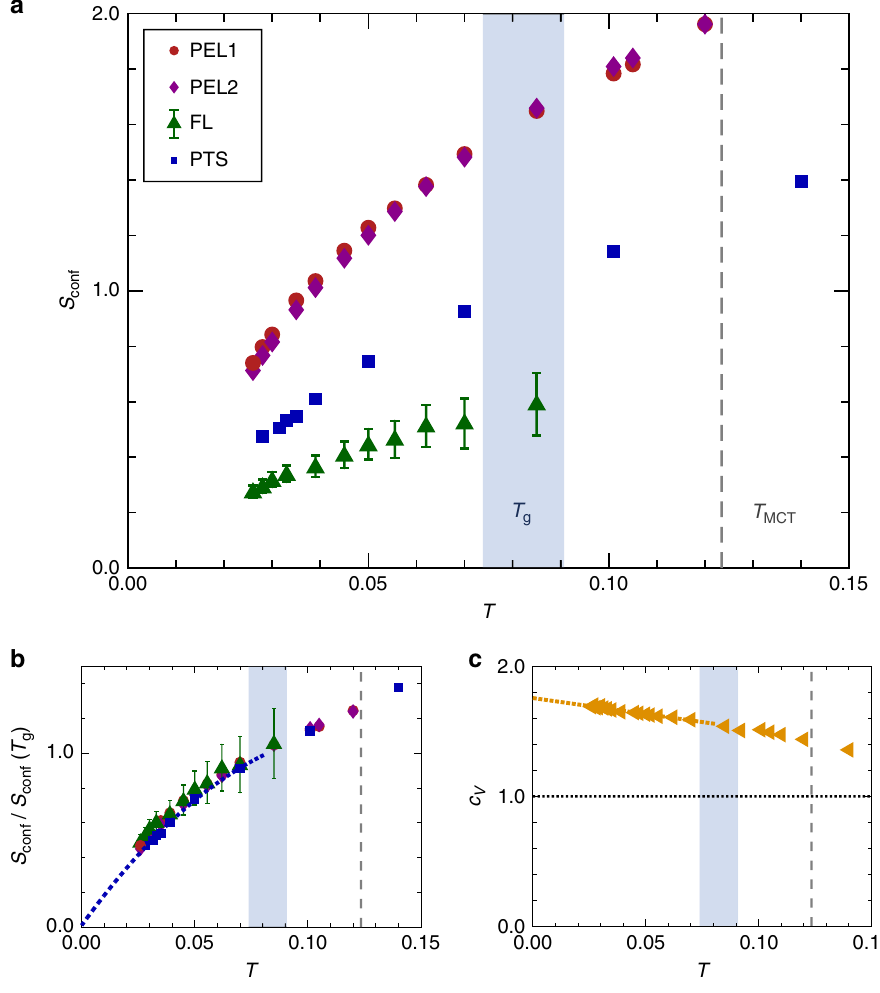
Fig. 2 Zero-temperature Kauzmann transition. a Decrease of the con fi gurational entropy with temperature using the potential energy landscape (PEL), Frenkel – Ladd (FL), and point-to-set (PTS) length estimates. The error bars for FL correspond to the ambiguity of de fi ning the plateau regime in the mean squared displacement of the FL construction. b Once rescaled by their value at T g , all estimates evolve nearly identically, and the collapsed data are well fi tted by a quadratic function of T for T < T s T )/ s T = 0.01 + 1.48( T / T − 0.49( T / T 2 indicates the quadratic fi t for the point- g (dashed blue line: conf ( conf ( g ) g ) g ) to-set estimate). All results are consistent with a linearly vanishing s conf at T K = 0. c The speci fi c heat, c V , obtained from the derivative of the potential energy increases monotonically above the Dulong – Petit law for d = 2 (dashed horizontal line), which is also consistent with a thermodynamic transition at T K =